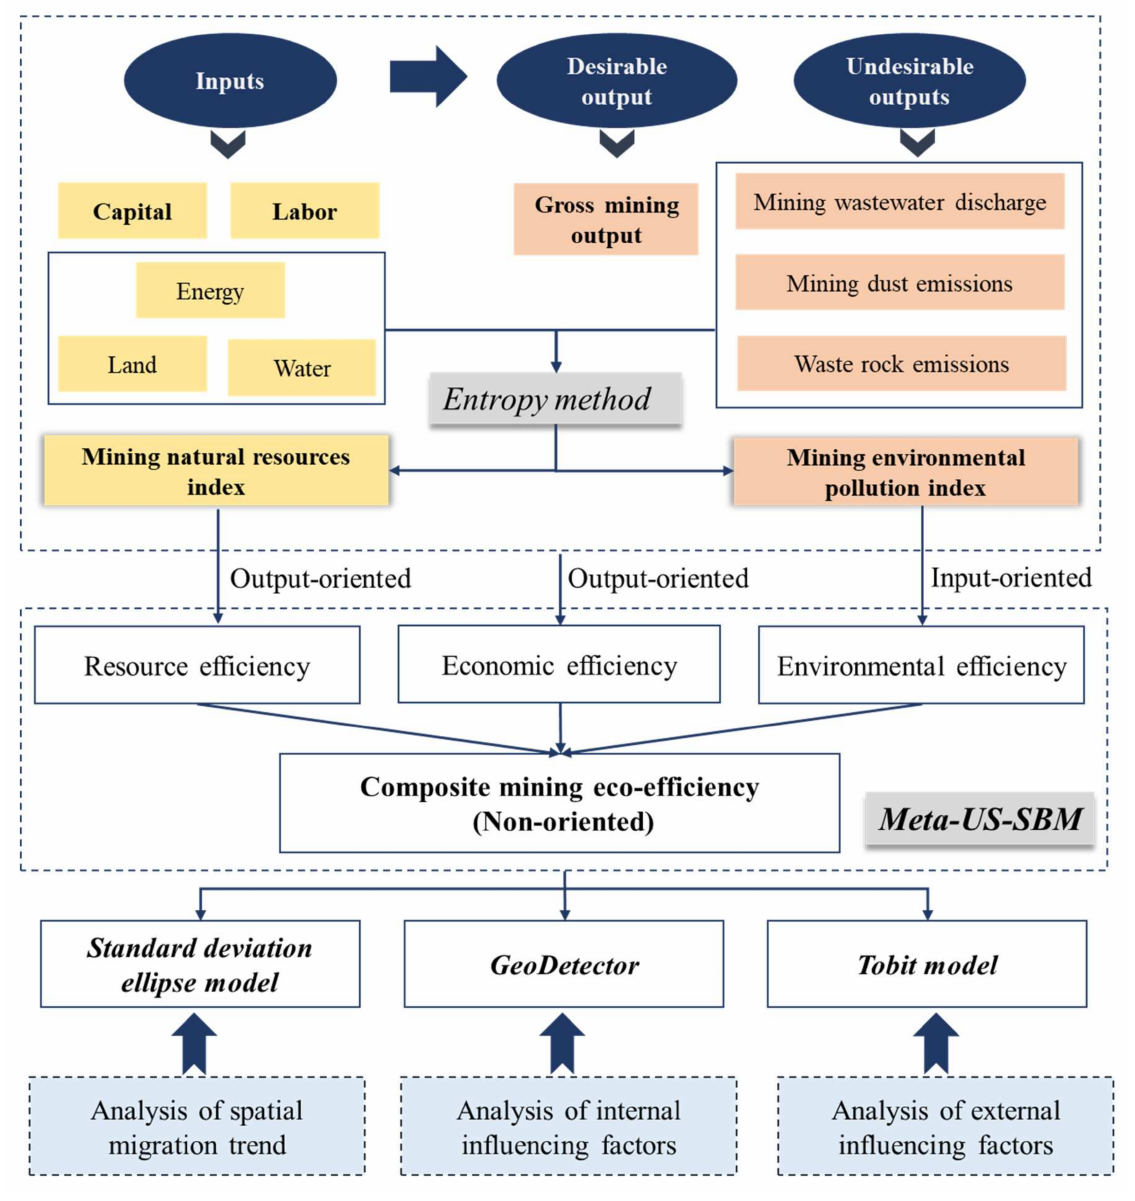
Figure 2. Research